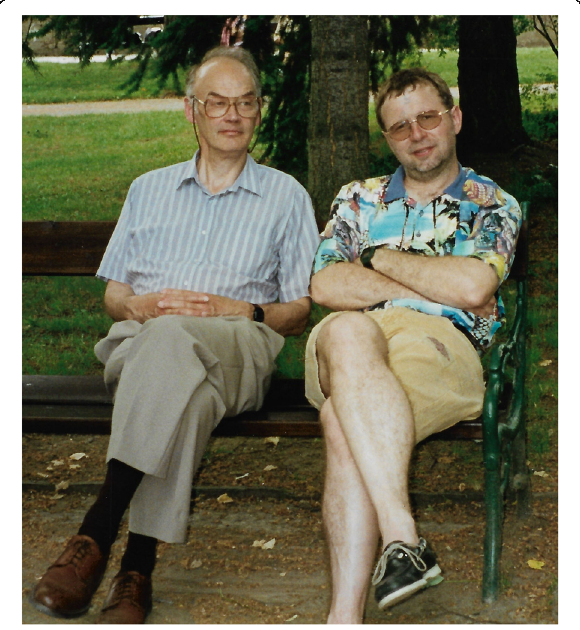
Fig. 28 John W. Sheard ( left ) and Helmut Mayrhofer ( right ) in Graz, Austria, on the occasion of his second visit, 1998. Photo: Eleonora